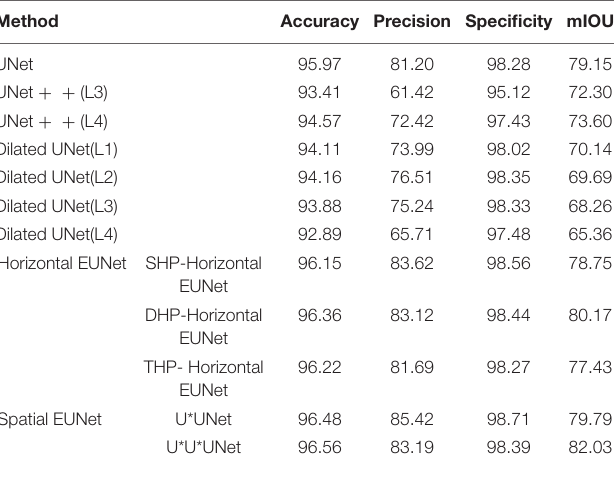
TABLE 3 | Segmentation performance comparison between EUNet and U-shaped network in DRIVE.